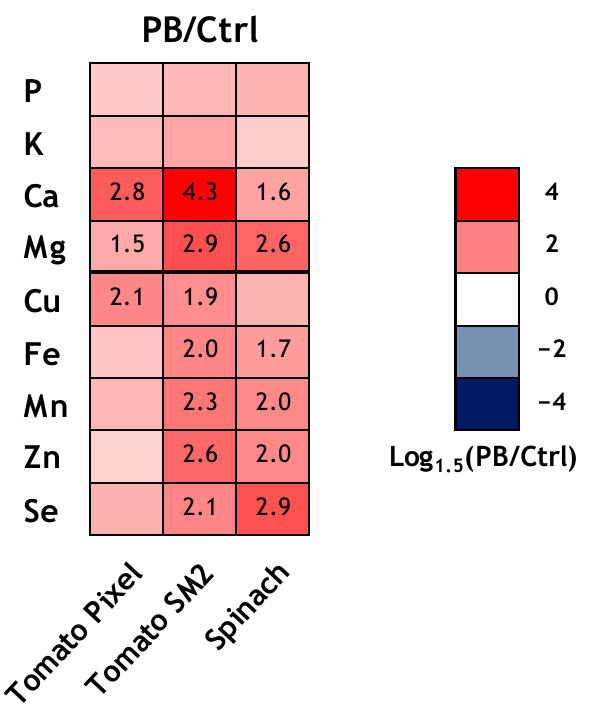
Figure 1. Heat map analysis summarizing macro- and micronutrients variations in Pixel and San Marzano tomato fruits, and spinach plants under T. harzianum strain T22, tropical plant extract or vegetal-derived protein hydrolysate biostimulant treatments vs. respective controls. Results were calculated as Logarithm base 1.5 (Log 1.5 ) of plant biostimulants treatments/control values (PB/Ctrl). Results were visualized using a false color scale, with red indicating an increase and blue a decrease of values relative to those in control condition. No differences were visualized by white squares.